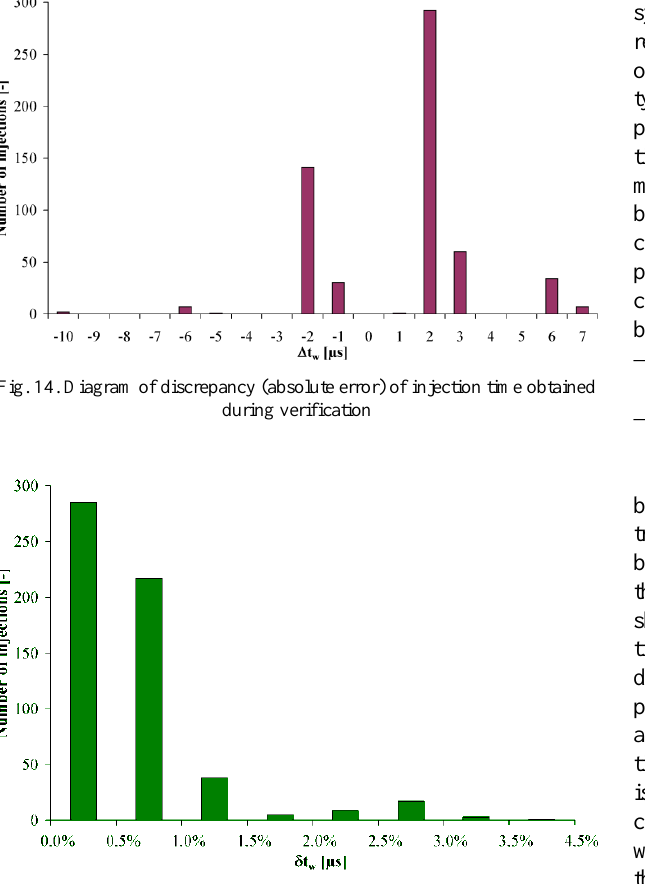
Fig. 15. Diagram of the relative error of injection time obtained during